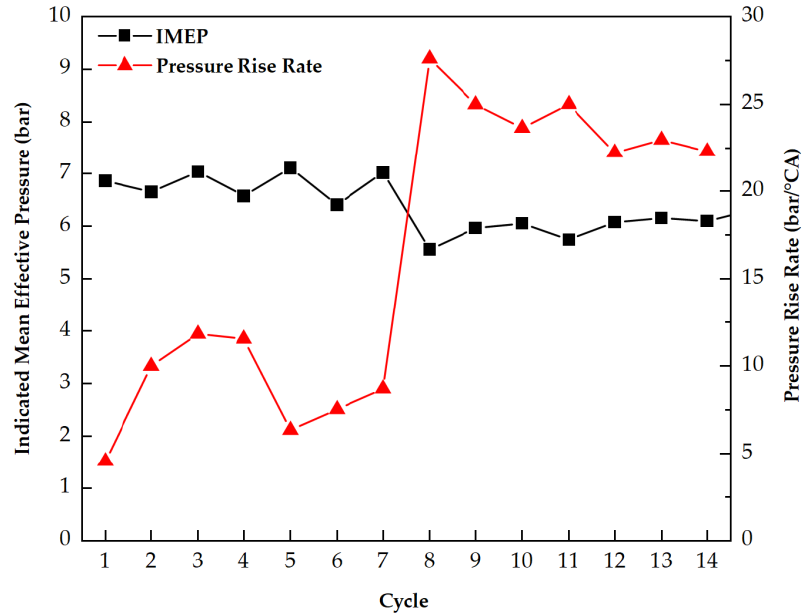
Figure 12. The IMEP and pressure rise rate changes during switching.